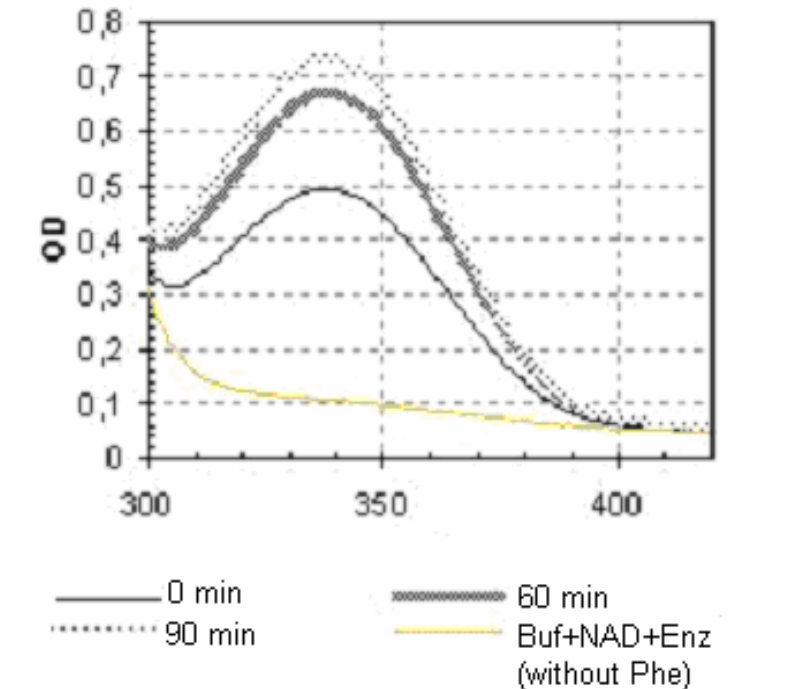
Figure 4. A fragment of spectra of the reaction (1), taken within the range of wavelength 300 - 420 nm. Sample composition: 10 mM Phe, 0.4 mM NAD + , 2 U/200 µl PheDH, 5 mM NaH of pH